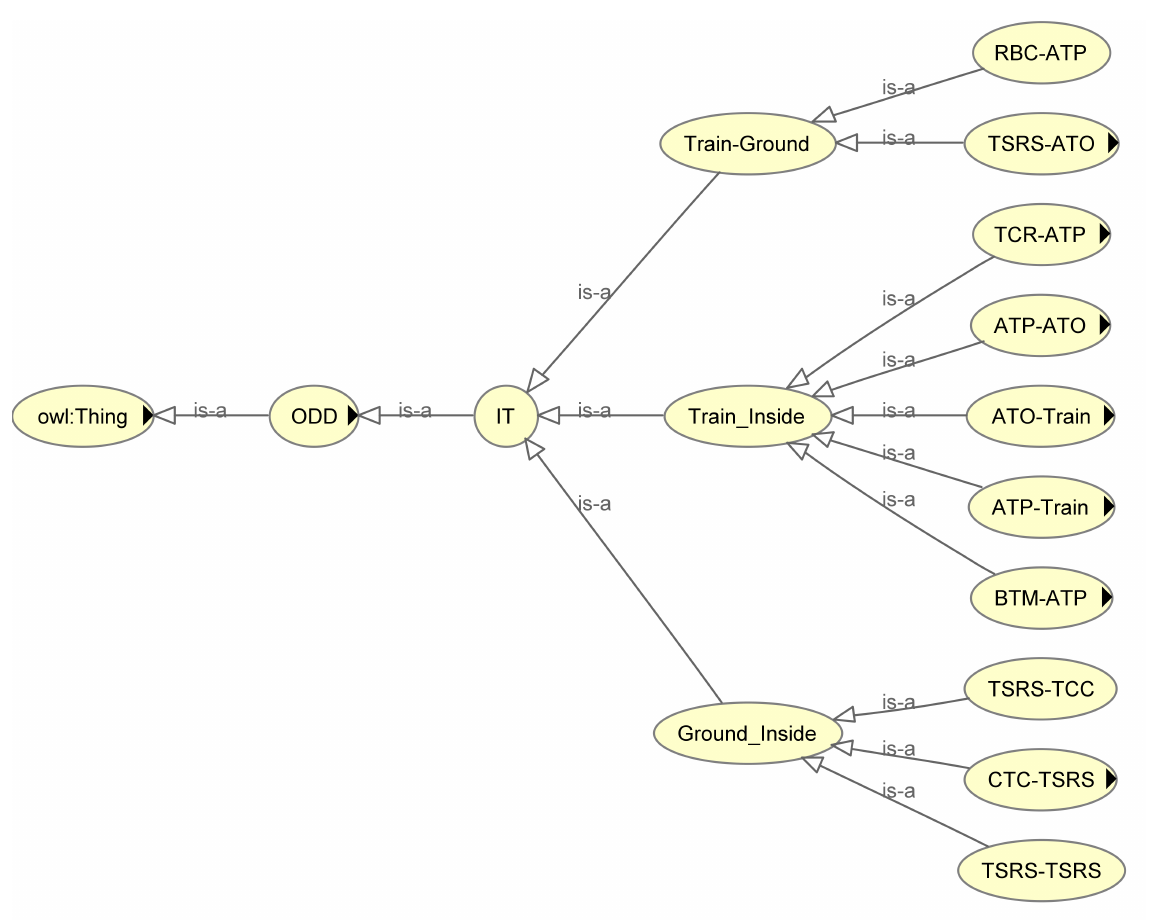
Figure 7. Structure diagram of information